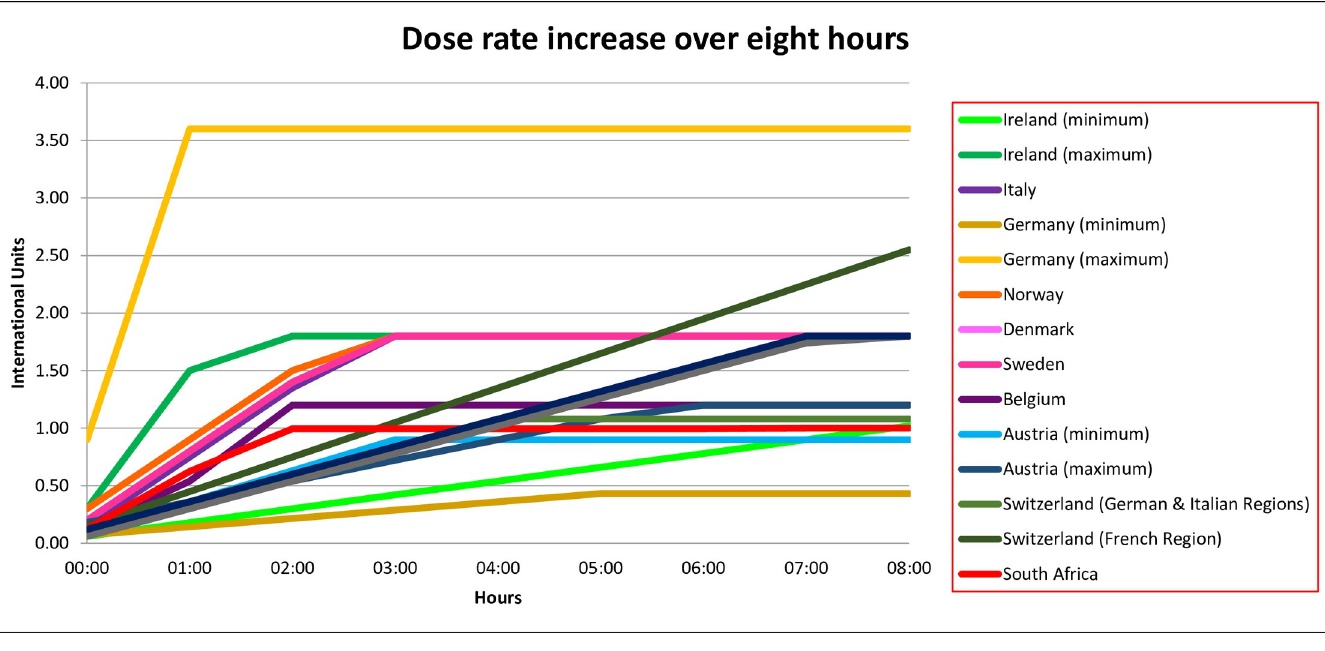
Fig 1. Dose rate increase over an eight-hour